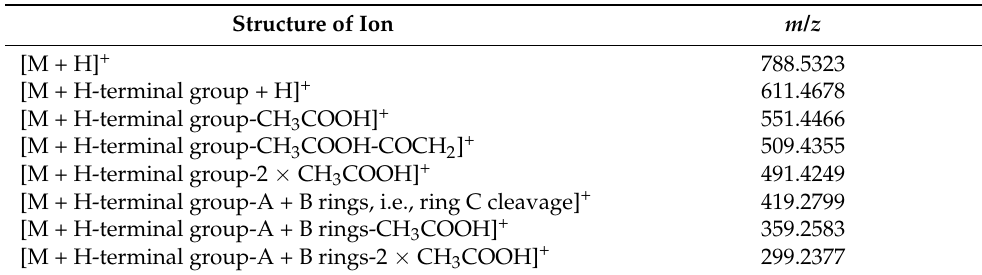
Table 2. Assignment of ions observed in tandem mass spectra of peracetylated adenosylhopane described in the